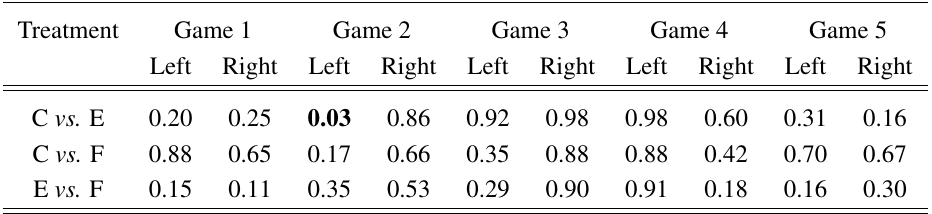
Table 7. Two-sided p -values of the Z -tests that compare the mean disapproval rates across treatments. C = control treatment, E = expectations treatment, F = feedback